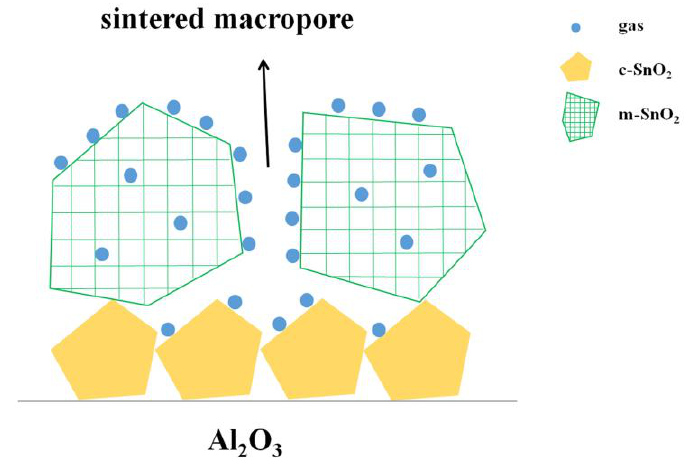
Figure 14. Schematic drawing of the possible gas sensing mechanism of the gas sensors.